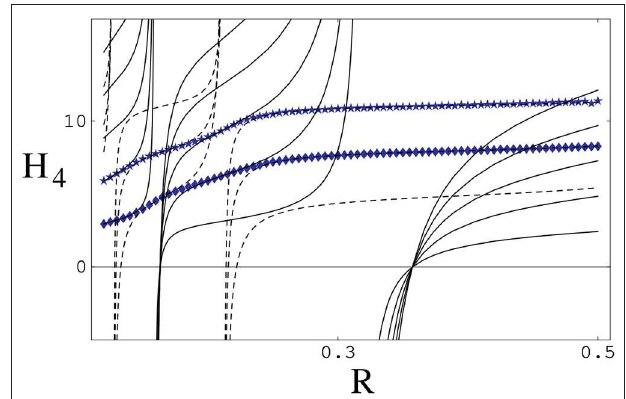
FIGURE 3 | Dependence of H 4 2 µ R 2 V S ( R ) for n 4 on R (in units of r 0 ). ≡ p − = Two analytical approximations, Equation (21) (solid lines) and Equation (22) (dashed lines), are shown together with a numerical solution of Equation (20) (bold lines) that interpolates between them. Reprinted figure with permission from reference [23]. Copyright (2001) by the American Physical